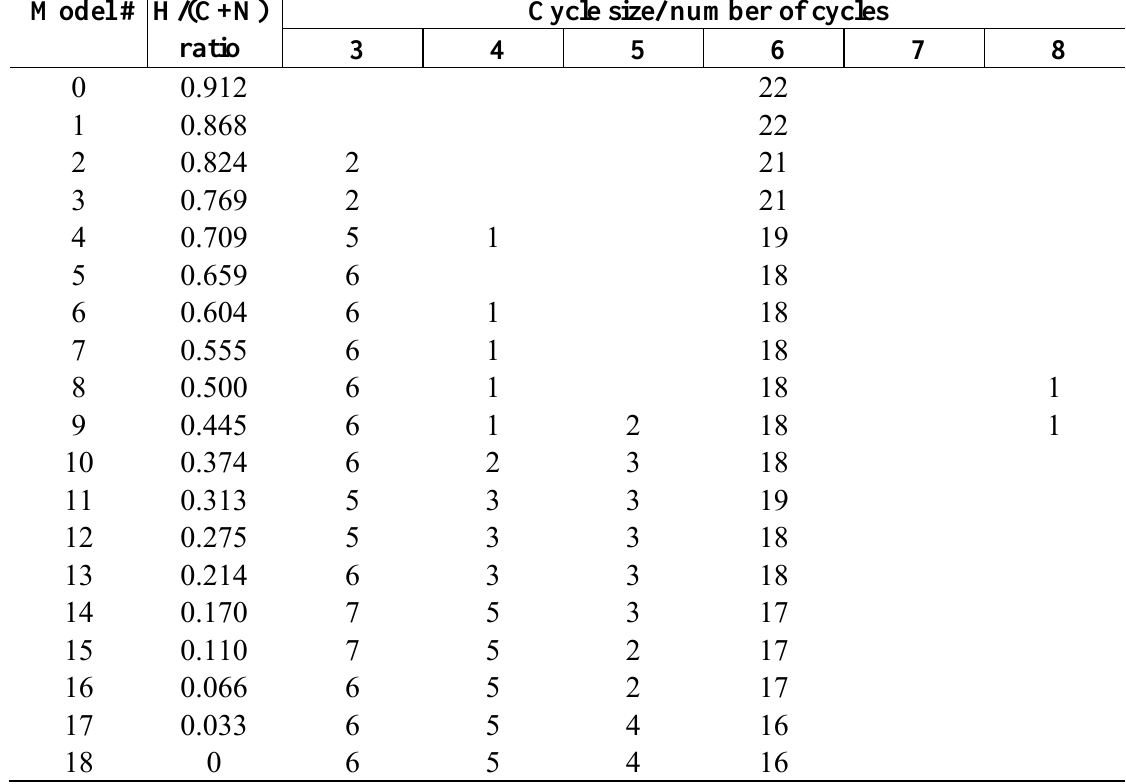
Table 3. The dependence of the cycles distribution in periodic models on the H/(C+N) ratio. Model #